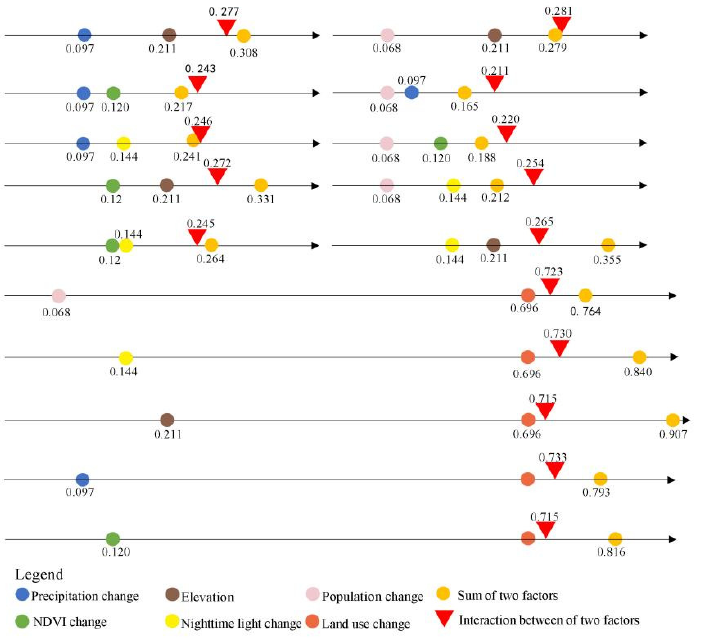
Figure 6. Results of interaction detection of factors influencing habitat quality in Wenzhou City.